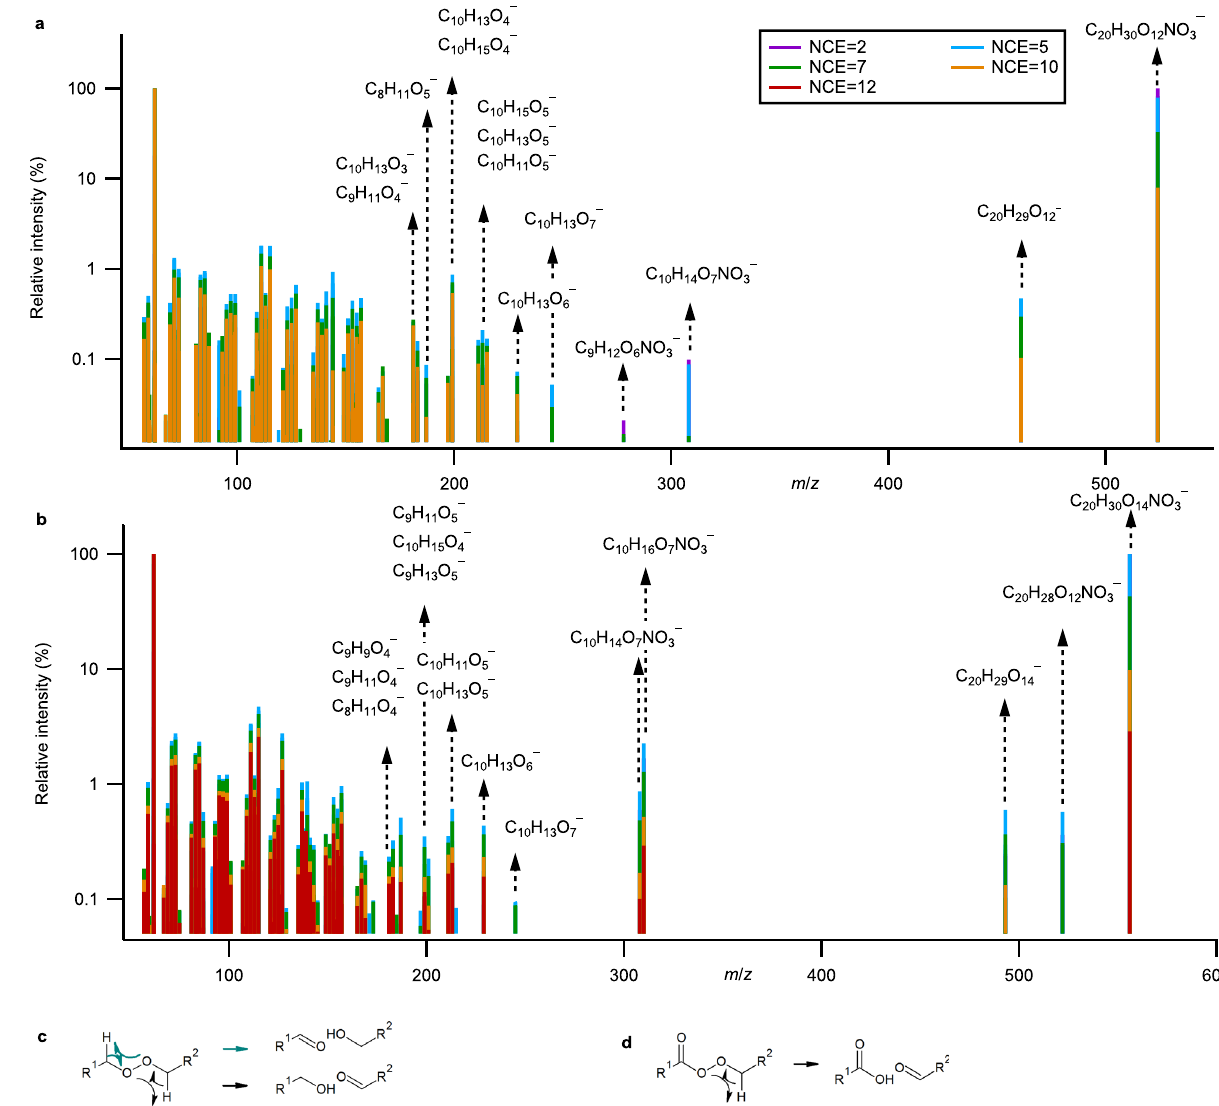
Fig. 4 MS/MS spectra of two limonene ozonolysis dimers at various NCE (2 – 10). a MS/MS spectra of C 20 H 30 O 12 NO 3 – . b MS/MS spectra of C 20 H 30 O 14 NO 3 – . c MS/MS fragmentation mechanism of RO – OR for dimers produced from the reaction involving two peroxy radical precursors, which can proceed via either of the black or green pathways. d MS/MS fragmentation mechanism of RO – OR for dimers produced from the reaction involving an acylperoxy radical and a peroxy radical, where only one pathway is